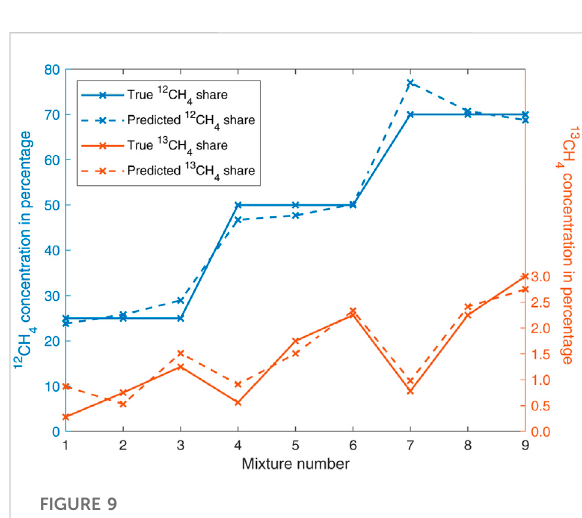
FIGURE 9 Evaluation of the investigated methane isotopologue mixtures by leave-one-out cross-validation based on